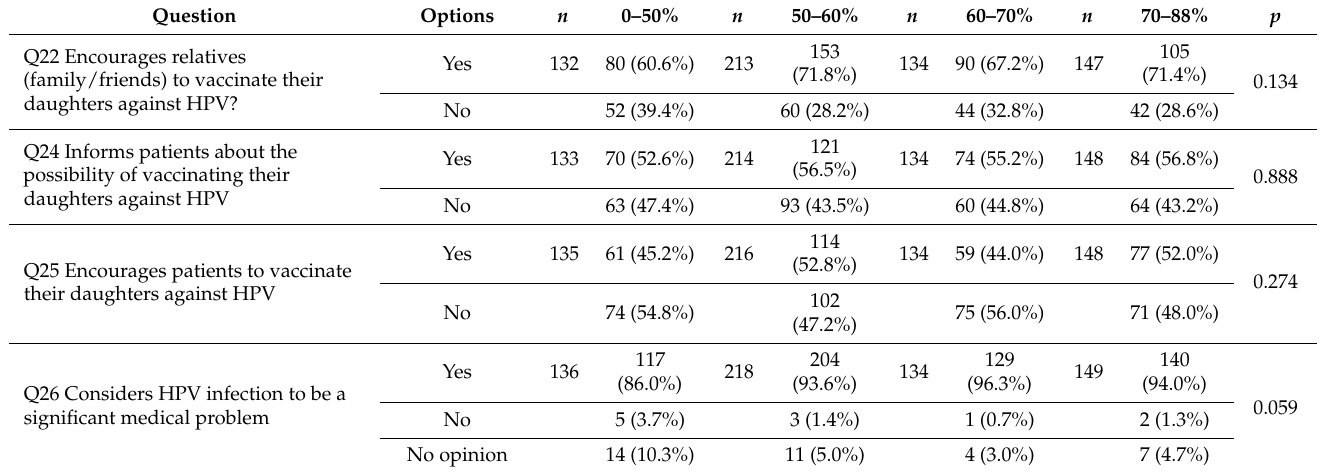
Table 9. Doctors’ attitude to HPV vaccinations depending on test